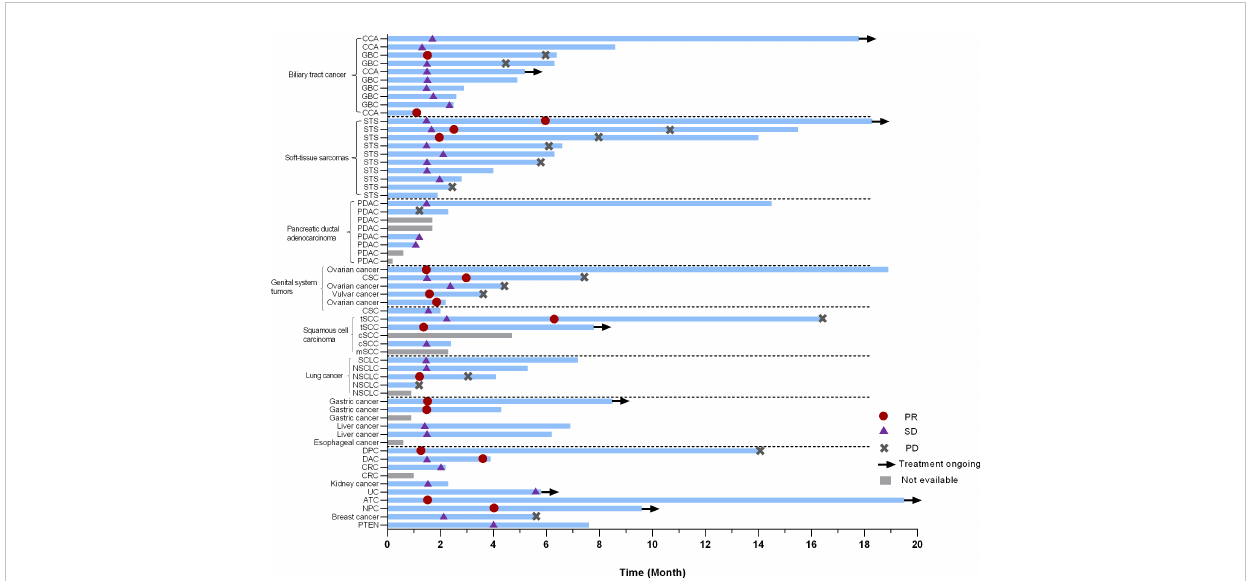
FIGURE 2 Swimmer plot according to cancer type. PR, partial response; SD, stable disease; PD, progressive disease; CCA, cholangiocarcinoma; GBC, gallbladder carcinoma; STS, soft-tissue sarcomas; SCLC, small lung cancer; NSCLC, non-small lung cancer; PDAC, pancreatic ductal adenocarcinoma; CSC, cutaneous squamous cell carcinoma; tSCC, thymic squamous cell carcinoma; cSCC, cutaneous squamous cell carcinoma; mSCC, metastatic squamous cell carcinoma of unknown primary;DPC, duodenal papilla carcinoma; DAC, duodenal adenocarcinoma; CRC, colorectal cancer; UC, Urothelial carcinoma; ATC, Anaplastic thyroid carcinoma; NPC, nasopharyngeal carcinoma; PNET, pancreatic Neuroendocrine Tumor.